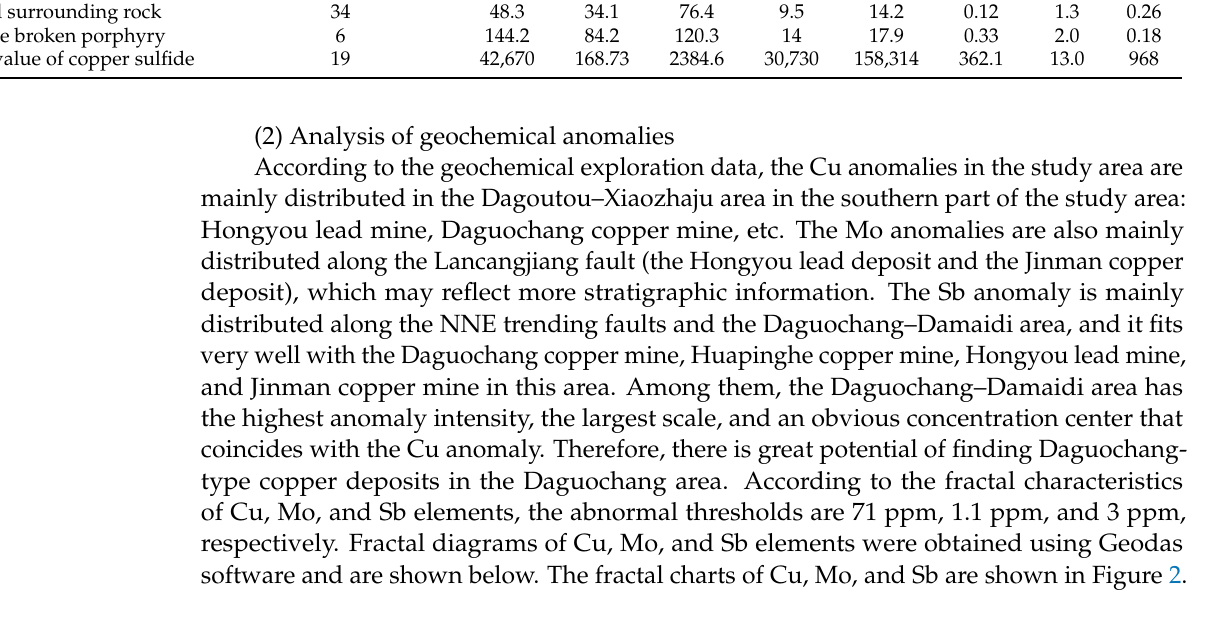
Figure 3. Anomaly map of Cu, Mo, and Sb element combinations (unit: ppm). 4.2. Remote Sensing Geological Interpretation This paper uses Landsat TM image data and ETM+ image data as remote sensing data sources. The maximum spatial resolution of TM data is 30 m with a total of seven spectral bands. The maximum spatial resolution of ETM+ data is 15 m with a total of eight spectral bands. Through remote sensing interpretation, it can be seen that metal mineral- ization in this area is often accompanied by sericitization, potassium chloride, and kaolin- ization. These minerals usually contain hydroxyl functional groups (OH). Carbonate min- erals such as dolomite, calcite, and rhodochrosite often contain carbonate ions (CO 3 2 − ) [25]. Alteration minerals containing OH and CO 3 2 − have strong absorption in the ETM +